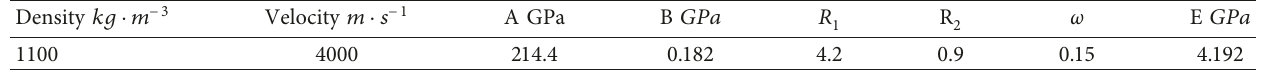
Table 1: The parameters of 2# emulsified explosives.